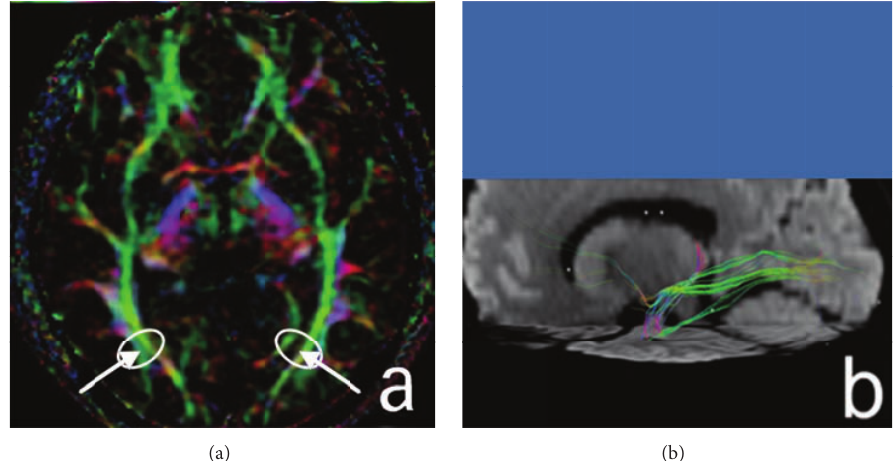
Figure 1: The GCT fibers ((a), white arrows) appear completely as green fiber tracts besides the paracele in healthy volunteers. It is a fiber tract from LGB and terminates in the calcarine fissure of occipital lobe (b).